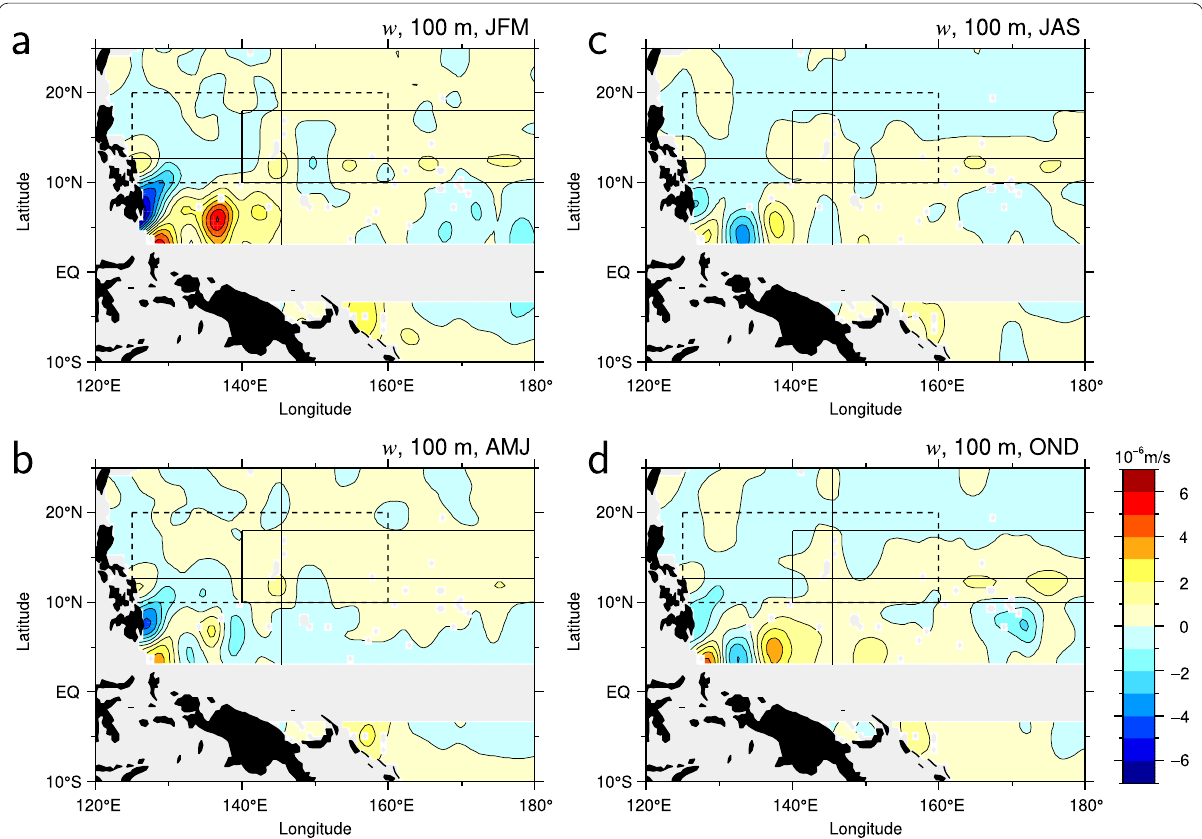
Fig. 7 Horizontal distribution of vertical velocity w at a depth of 100 m averaged in a January–March, b April–June, c July–September, and d October–December during 1993–2016. Positive values show upward velocity. Contour intervals are 1 × 10 − 6 ms − 1 . Gray shadings indicate regions of no data because of small values of the Coriolis parameter and shallow water depth. Zonal and meridional thin solid lines denote locations of the w sections shown in Figs. 8b–e and 9b–e. Dotted square delineates the region where Nagano et al. (2016a) studied the QD variation in SST. In the solid square, vertical volume and temperature transports and SST tendency due to the vertical current variation were calculated as in Fig.